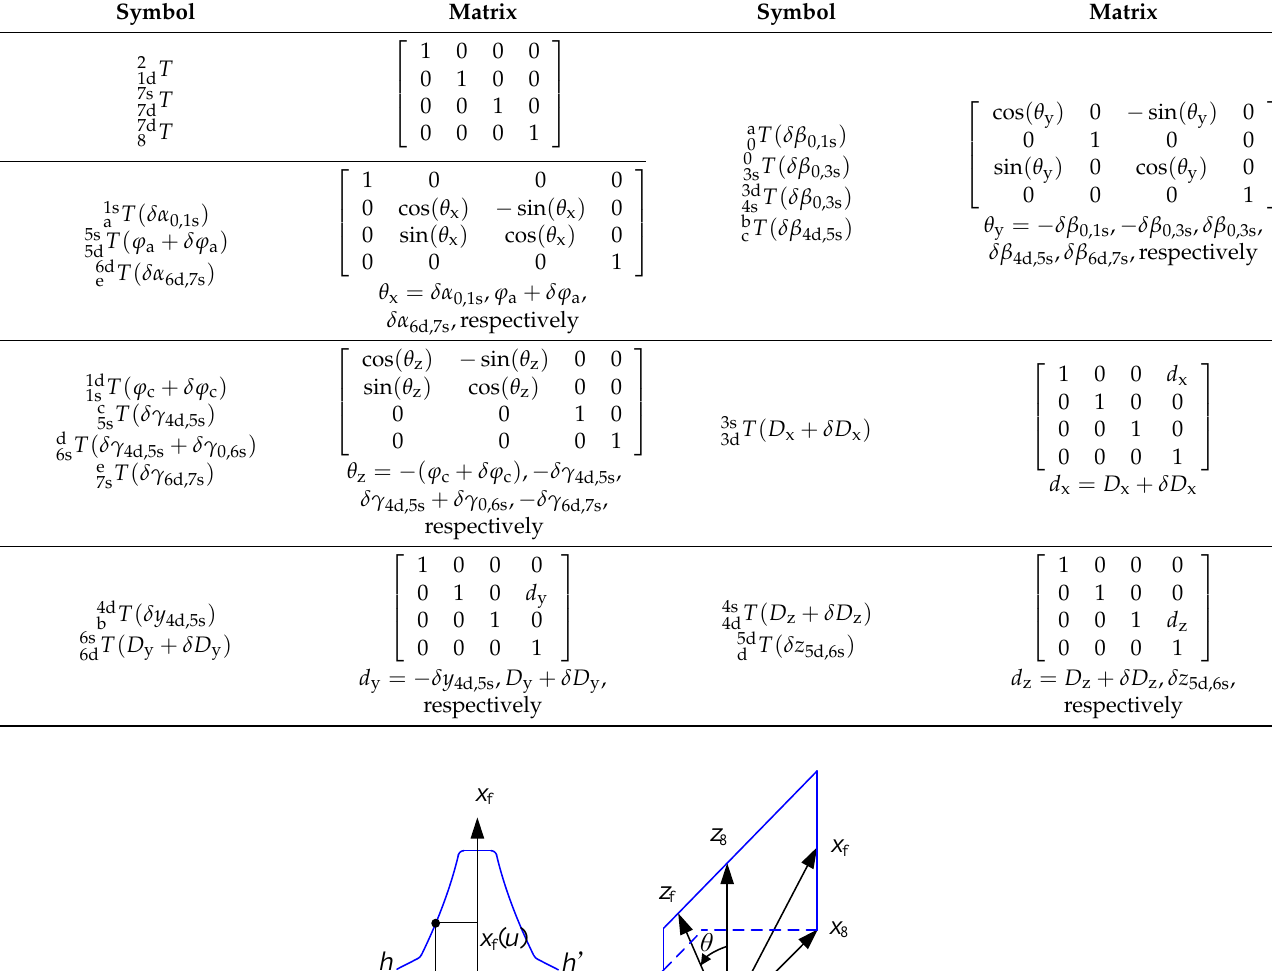
Table 2. Coordinate transformation matrix of two adjacent coordinate systems.